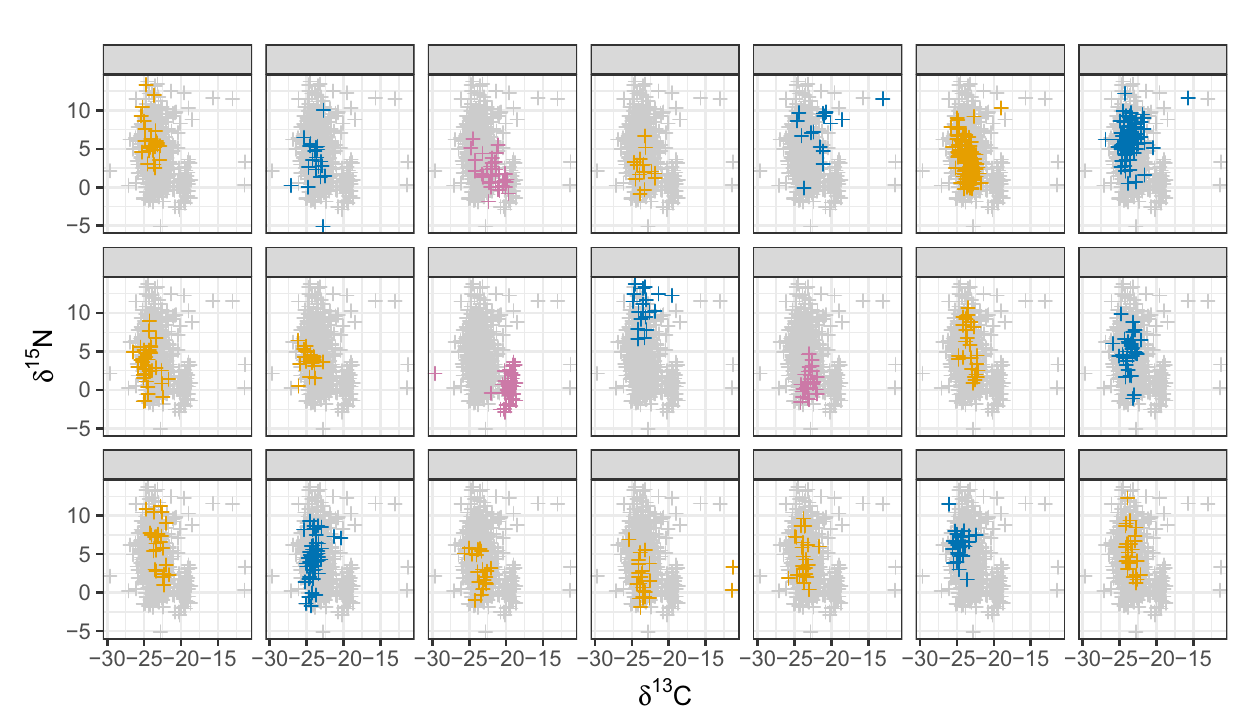
Figure 1. Distribution of each species and individuals over the δ 13 C- δ 15 N isotope space defining the dietary niche. Grey crosses in the background show the overall space occupied by the species (acronyms provided in Table S1). TSM Trans-Saharan migrants, IPM Intra-Palearctic migrants, IRM Irruptive